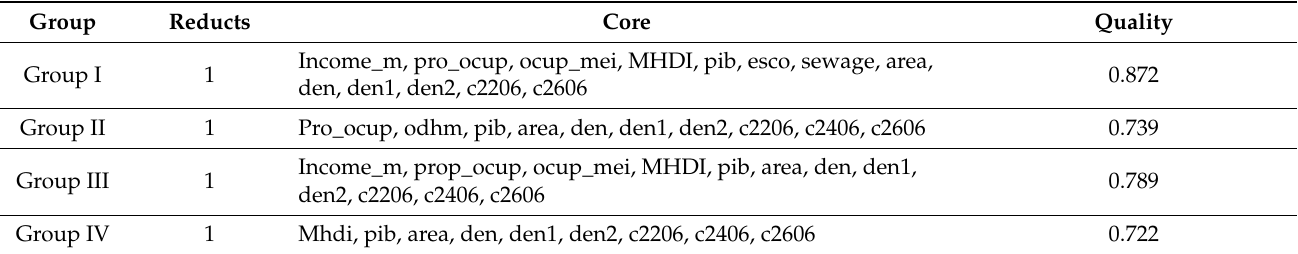
Table 9. Parameters generated via DRSA in relation to reference objects in 2021.